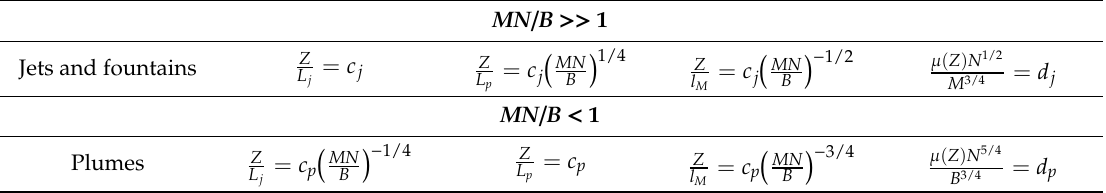
Table 1. Summary of the asymptotic relationships resulting from dimensional analysis. MN / B >>